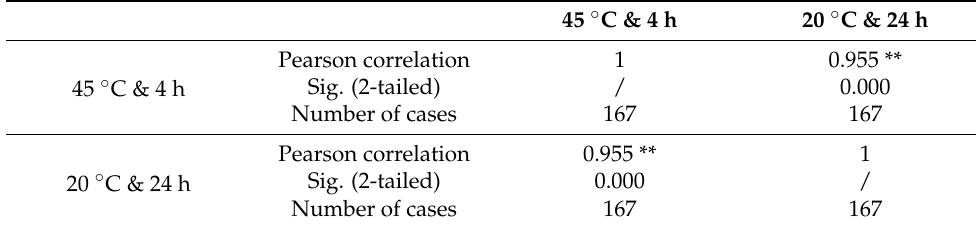
Figure 2. Correlation analysis scatter plot of formaldehyde emissions at 45 °C for 4 h and 20 °C for 24 h. Table 7. Correlation analysis of formaldehyde emissions at 45 °C for 4 h and 20 °C for 24 h.